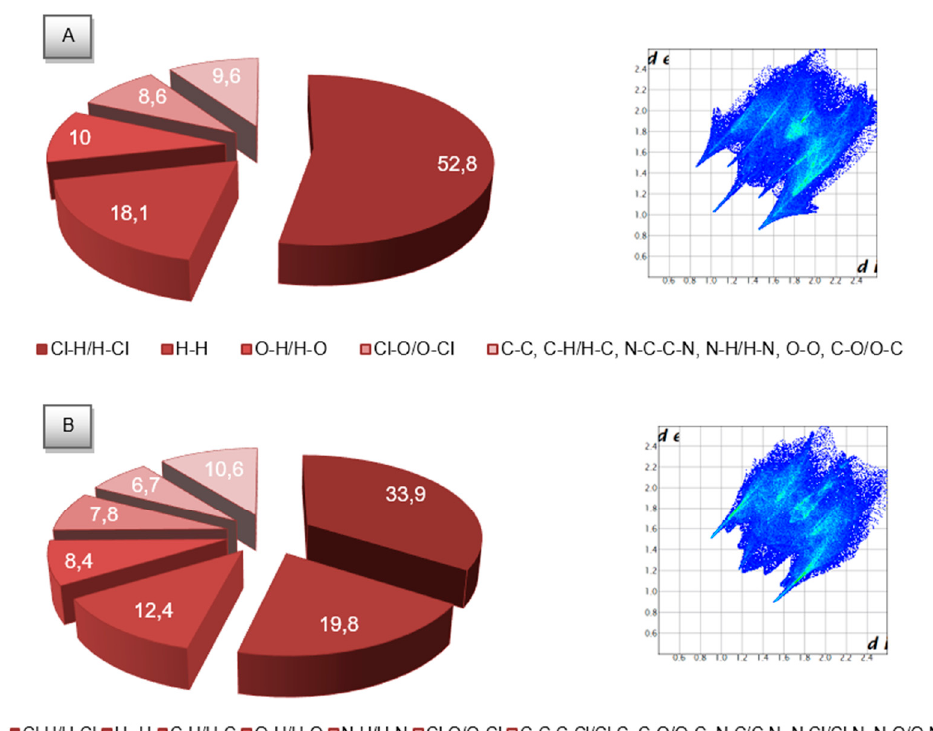
Figure 6. The 2D fingerprint plots of the most significant intermolecular interactions for complexes 1 ( A ) and 2 ( B ) with percentage of interaction.